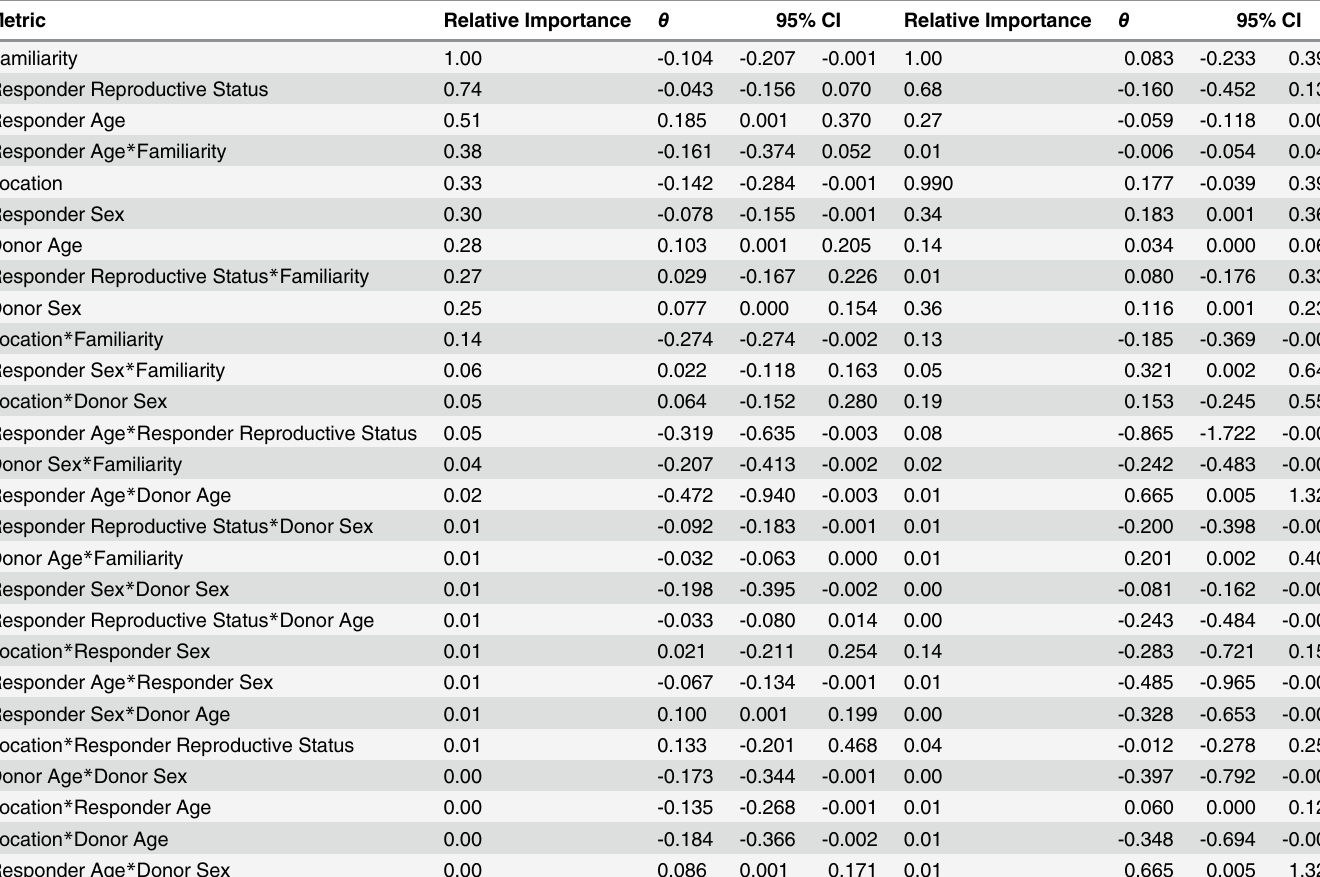
Table 4. Model averaging for the parameters linking sniffing and over-marking responses of badgers for the restricted dataset ( n = 187) including responder characteristics within the linear model. The Relative Influence of each parameter (based on Akaike weights) is presented along with model- averaged estimated values of their coefficients ( θ ), and 95% confidence intervals (CI). Asterisks ( * ) denote interaction